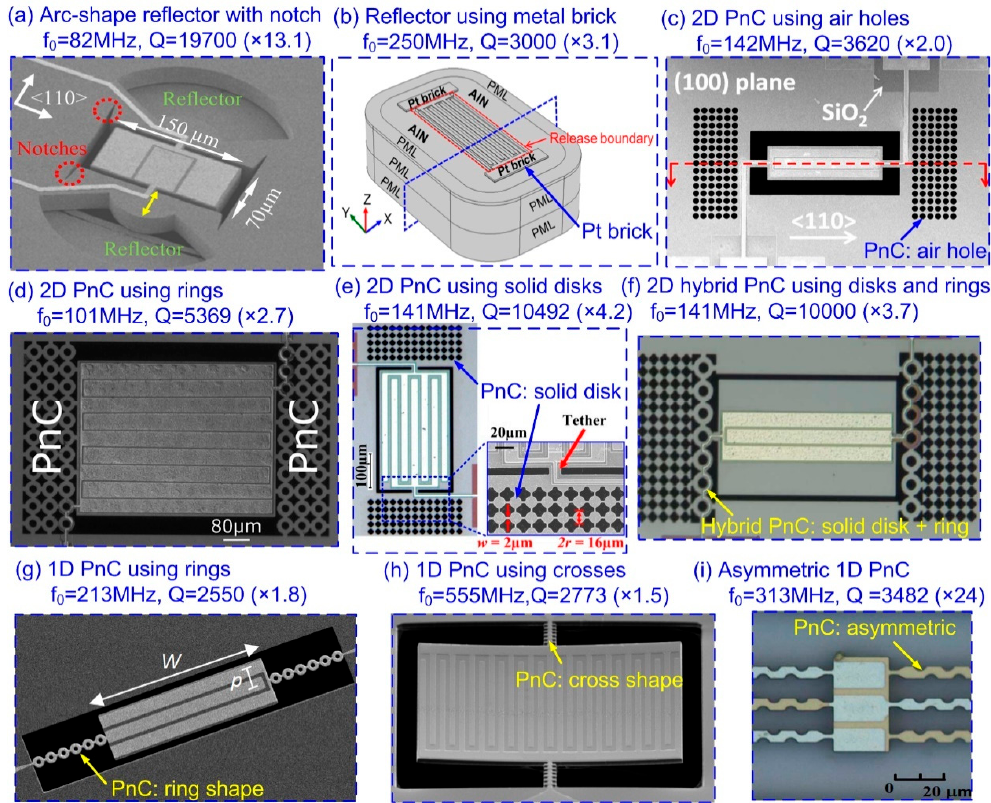
Figure 7. Q-enhancement strategies by placing acoustic reflectors on substrate or supporting tether: ( a ) SEM of an 82-MHz Al-on-Si LVR using etched arcs as acoustic reflectors together with etched notches. This figure is reproduced from [95] ( © 2018 IEEE); ( b ) schematic of a 250-MHz AlN LVR using Pt bricks as acoustic reflectors. This figure is reproduced from [96] (© 2019 IEEE); ( c ) SEM of a 143-MHz Al-on-Si LVR with 2D phononic crystals (PnC) arrays of air holes. This figure is reproduced from [97] (© 2015 IEEE); ( d ) SEM of an 101-MHz Al-on-Si LVR with 2D PnC arrays of rings. This figure is reproduced from [99] (© 2016 AIP Publishing); ( e ) SEM of a 141-MHz Al-on-Si LVR with 2D PnC arrays of solid-disks. This figure is reproduced from [104] (© 2018 MDPI); ( f ) SEM of a 141-MHz Al-on-Si LVR with hybrid 2D PnC arrays of solid-disks and rings. This figure is reproduced from [105] (© 2019 IEEE); ( g ) SEM of a 213-MHz AlN-on-Si LVR with ring-shape 1D PnC arrays. This figure is reproduced from [106] (© 2011 IEEE); ( h ) SEM of a 555-MHz AlN LVR with cross-shape 1D PnC array. This figure is reproduced from [107] (© 2014 IEEE); ( i ) Optical micrograph of a 313-MHz AlN-on-Si LVR with asymmetric PnC on the tethers. This figure is reproduced from [108] (© 2017 IEEE).